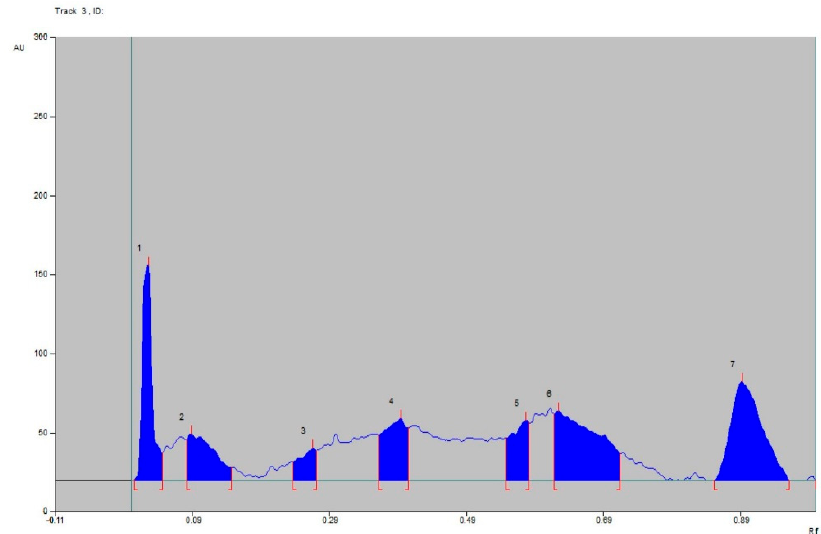
Figure 7. Chromatogram of ethanol extract of C. papaya.